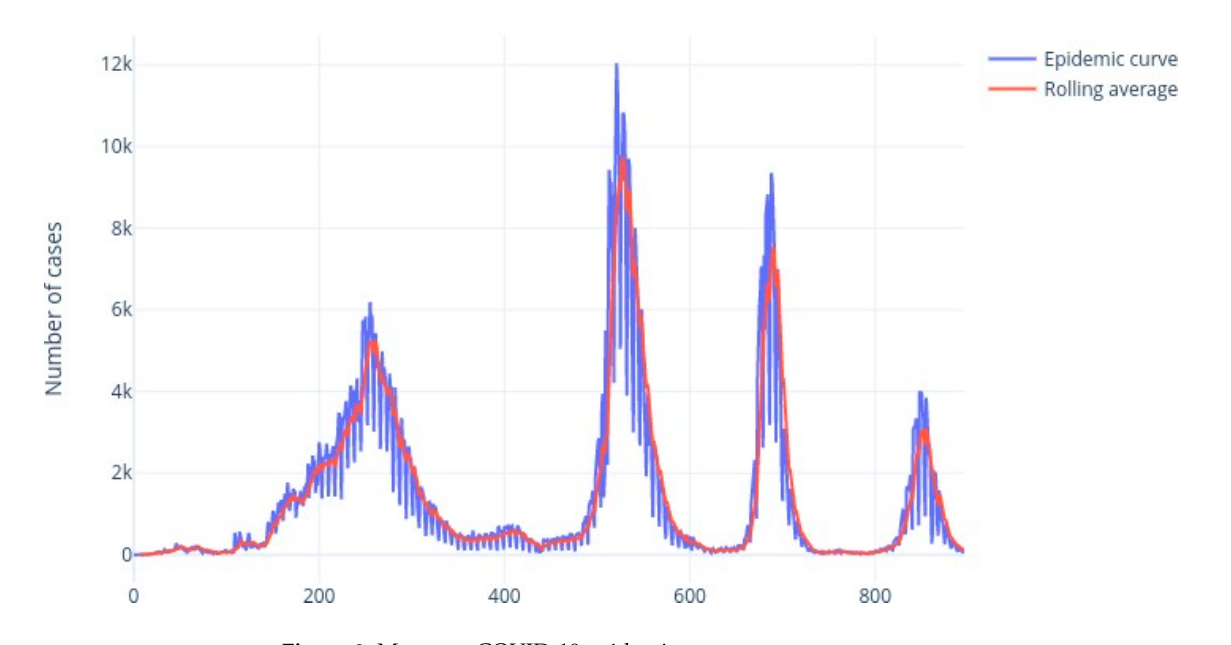
Figure 8. Morocco: COVID-19 epidemic curve.